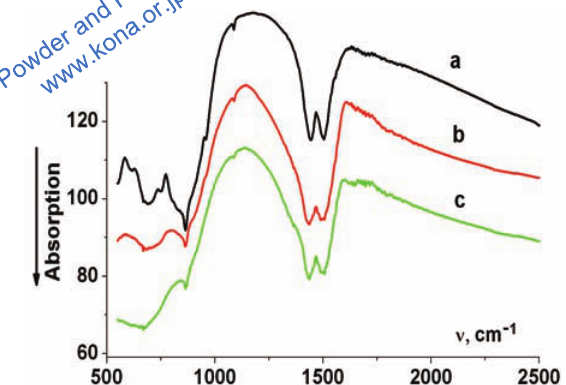
Fig. 2 IR absorption spectra of the samples containing 0.2 CuO: a) − initial composition; b) − mechanical acti- vation for 10 min;